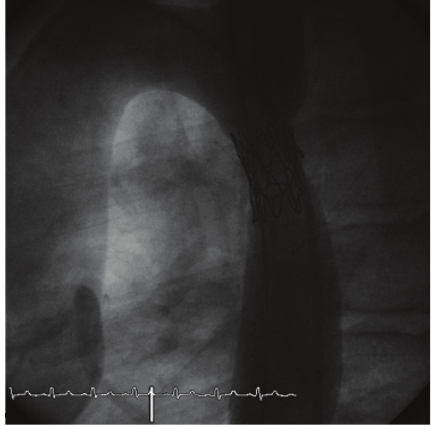
Figure 5: Lateral view: shortening and fracture of the stent after